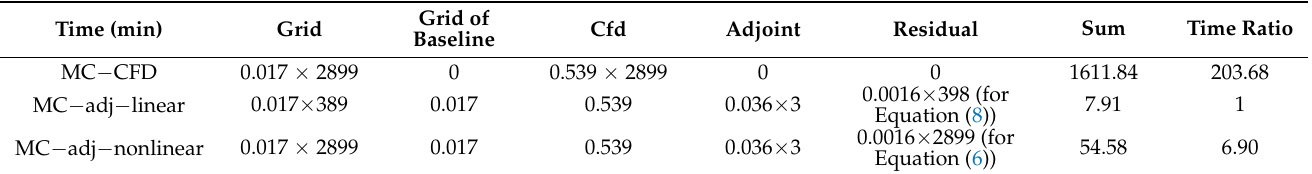
Figure 14. The normalized standard deviation of performance functionals at the design ( left ) and near-stall conditions ( right ) at 100% speeds and that of low pressure ratio ( left ) and high pressure ratio ( right ) operating points at 50% speed by the MC − adj − linear and MC − adj − nonlinear methods. Table 2. The UQ time-consumption of the three methods at the design condition (eight